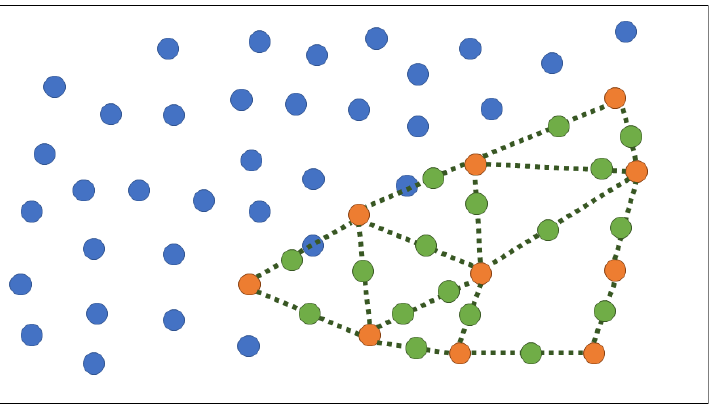
Figure 5. SMOTE processing. Blue indicates the majority dataset (non-respiratory failure). Orange indicates the minority dataset (respiratory failure). Green indicates the minority dataset (respiratory failure), which is generated by SMOTE.